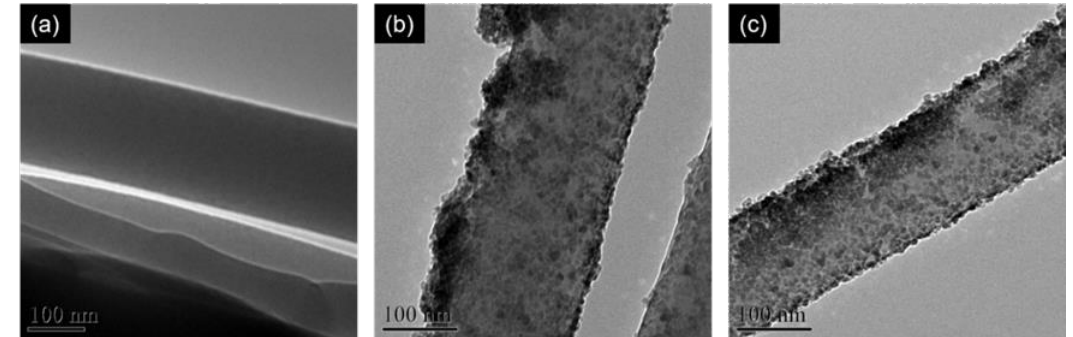
Figure 3. TEM images showing the surface morphologies of ( a ) an as-spun PEICT nanofiber, ( b ) a PEICT/ZnO composite nanofiber without post-electrospinning treatment with ethanol, and ( c ) PEICT/ZnO composite nanofibers treated with ethanol before ZnO nanoparticle loading.